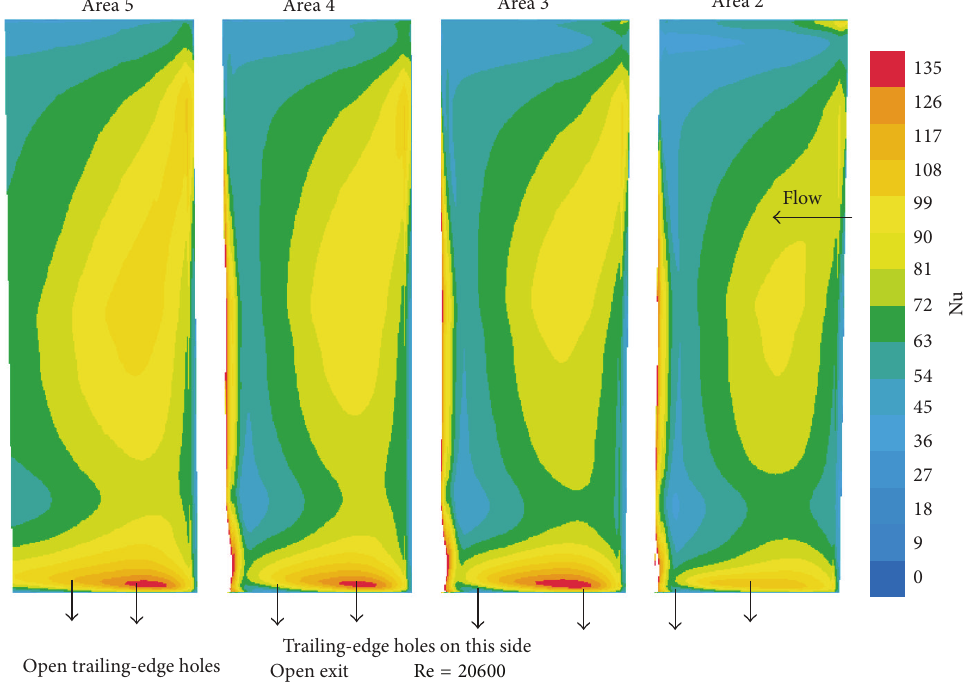
Figure 15: Contours of Nusselt number on Areas 2 through 5 on the concave wall, open trailing-edge holes, open exit, small ribs. small ribs. The superiority of the 𝑘 - 𝜀 model over the two other Finally, measured Darcy friction factors for all tested geo- models is evident. Numerical results for other geometries metries and flow arrangements are shown in Figure 20. The and flow arrangements produced the same trend and are not cluster of solid symbols on the upper side of the graph corres- presented here due to space limitation. ponds to the big ribs. Hollow symbols on the lower